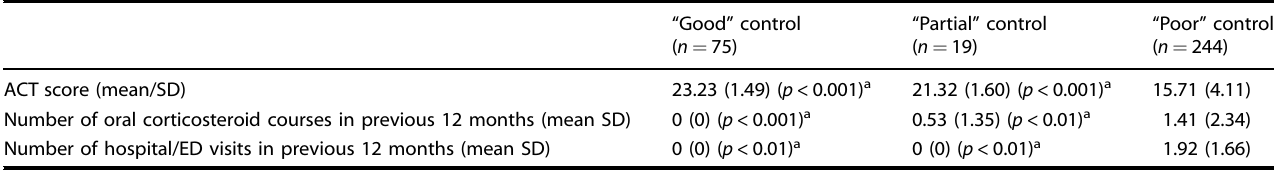
Table 2. Relationship between CGC de fi nition of asthma control and clinical